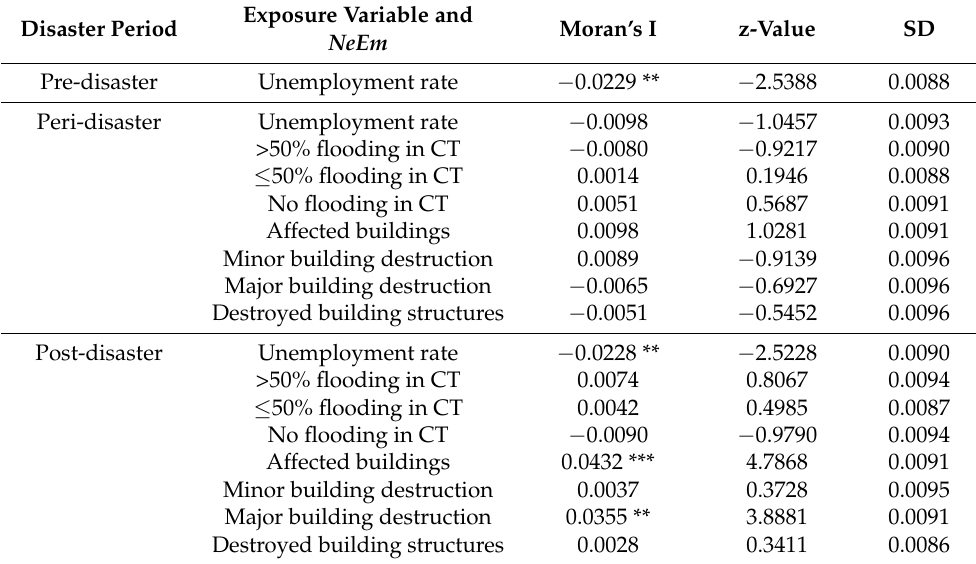
Table 2. Global bivariate Moran‘s I for exposure variables and combined negative emotions ( NeEm ) across three disaster periods. SD=Standard Deviation, CT= Census Tract. Significance values: *** <0.001, ** <0.01, * <0.05,